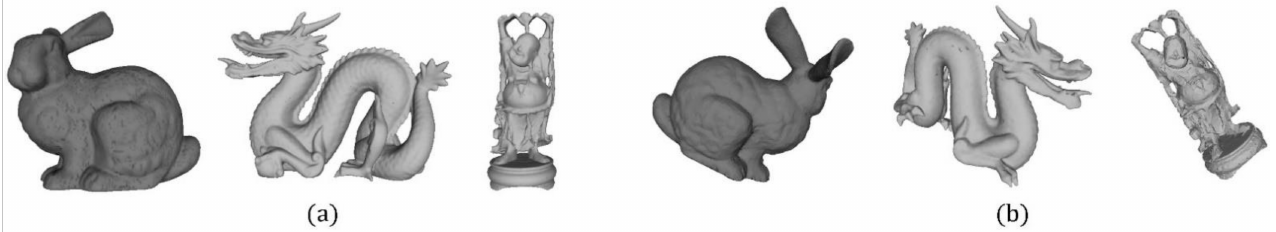
Figure 3. Examples on tuning dataset. ( a ) The examples of some models. ( b ) The examples of some scenes with 0.5 mr Gaussian noise and resampling 1/4 of model resolution.